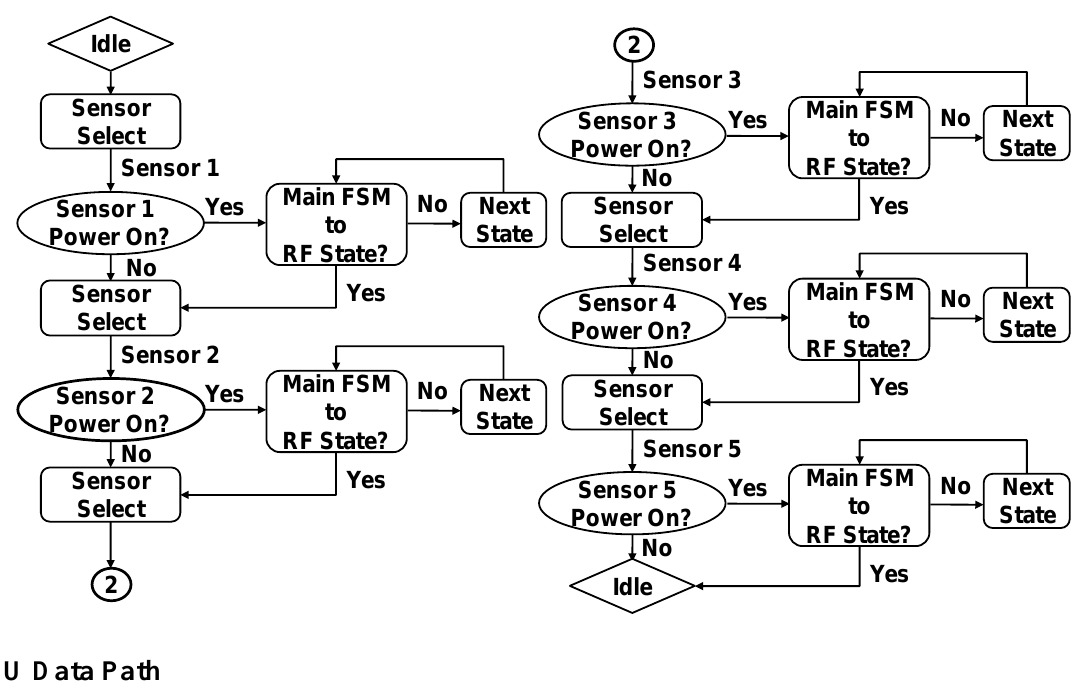
Figure 4. Control flow of multi sensor